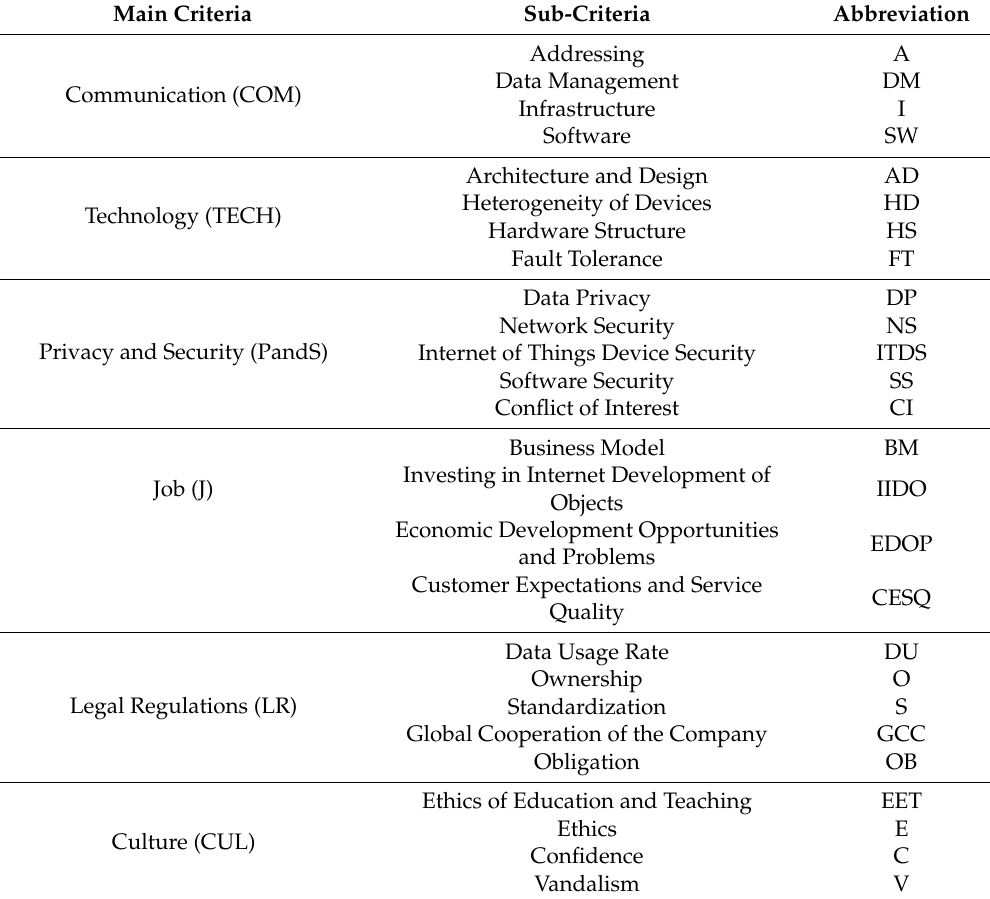
Table 1. Main criteria and sub-criteria.